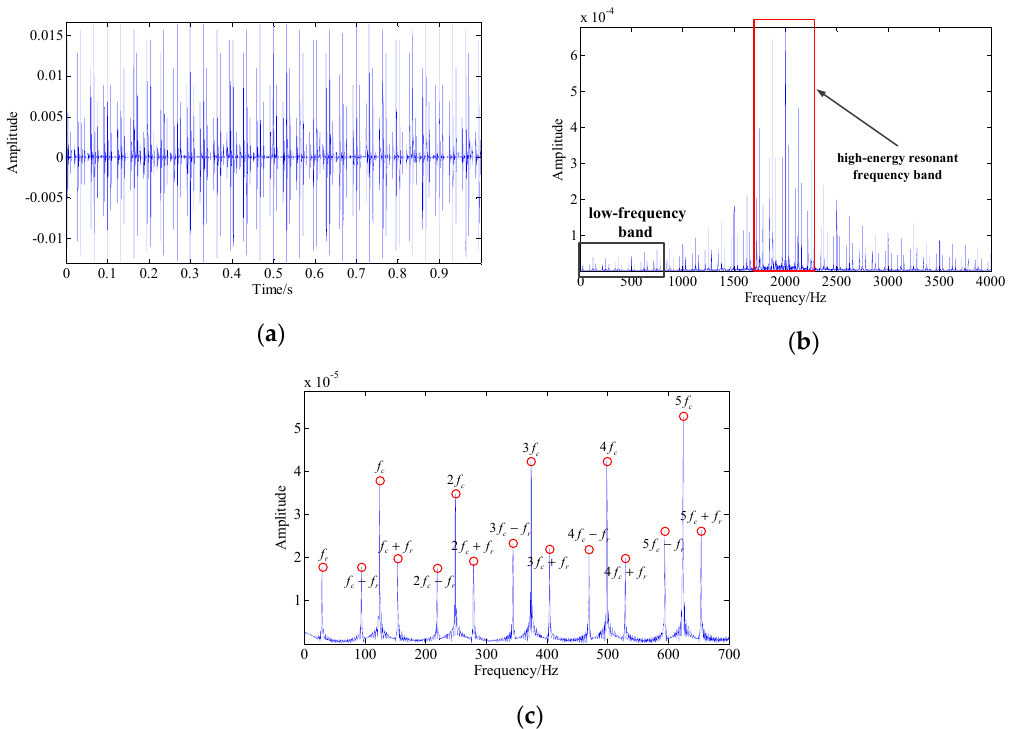
Figure 1. The simulated fault characteristic signal of the bearing inner race with a system resonance frequency of f n = 2000 Hz, a fault characteristic frequency of f c = 125 Hz, and a shaft rotation frequency of f r = 30 Hz: ( a ) simulated signal waveform; ( b ) simulated signal spectrum; ( c ) the low-frequency band (0–800 Hz) of the simulated signal spectrum.